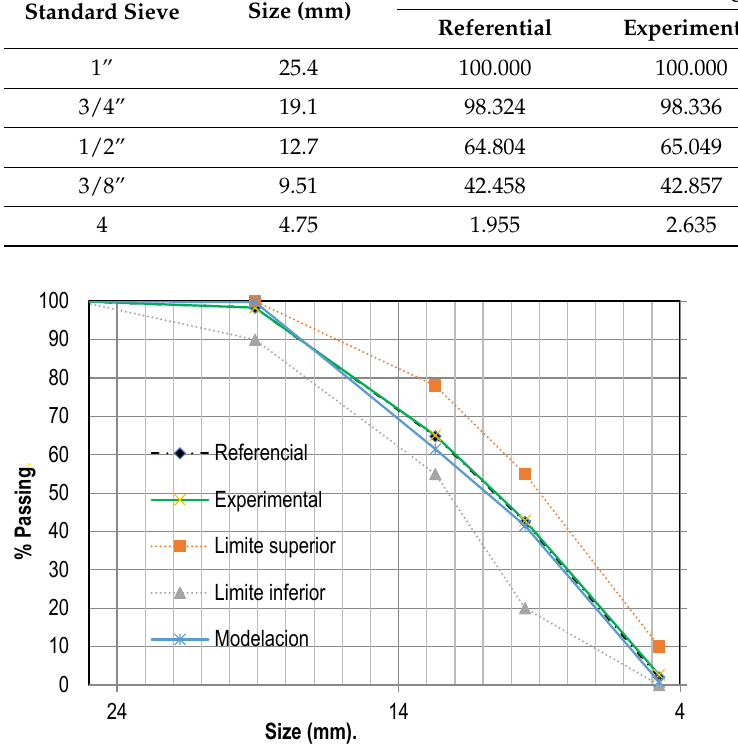
Figure 6. Granulometric curves used.